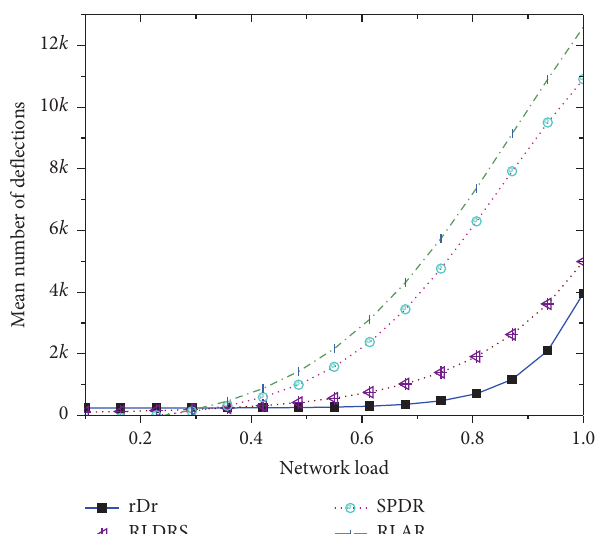
Figure 13: Mean number of deflections versus traffic load.